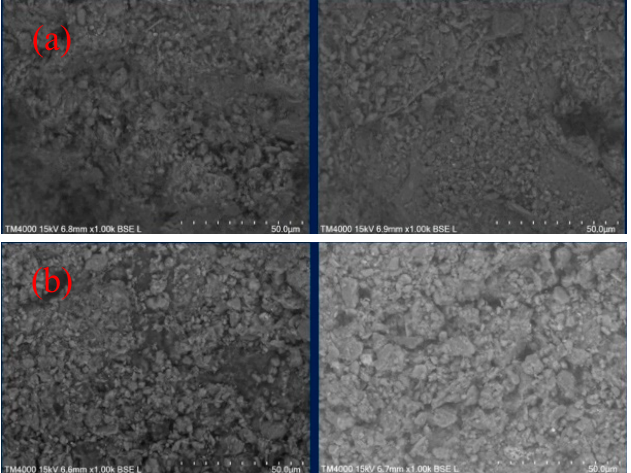
Figure 2 indicates the SEM images of samples affected by dynamic piling. Compared to the test images taken without pile driving, the microstructure uniformity of mudstone samples is negatively impacted by pile driving, and the porosity and fracture width increases.